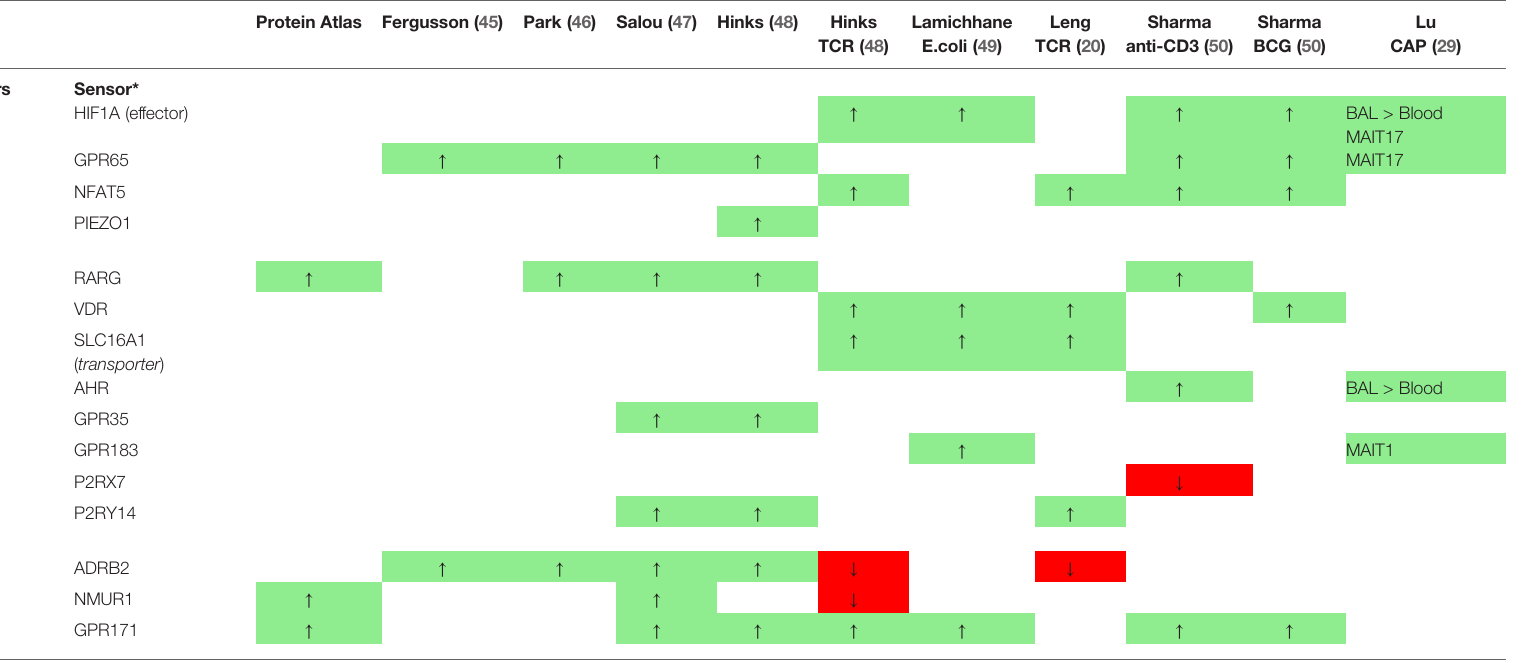
TABLE 2 | Environmental factors and